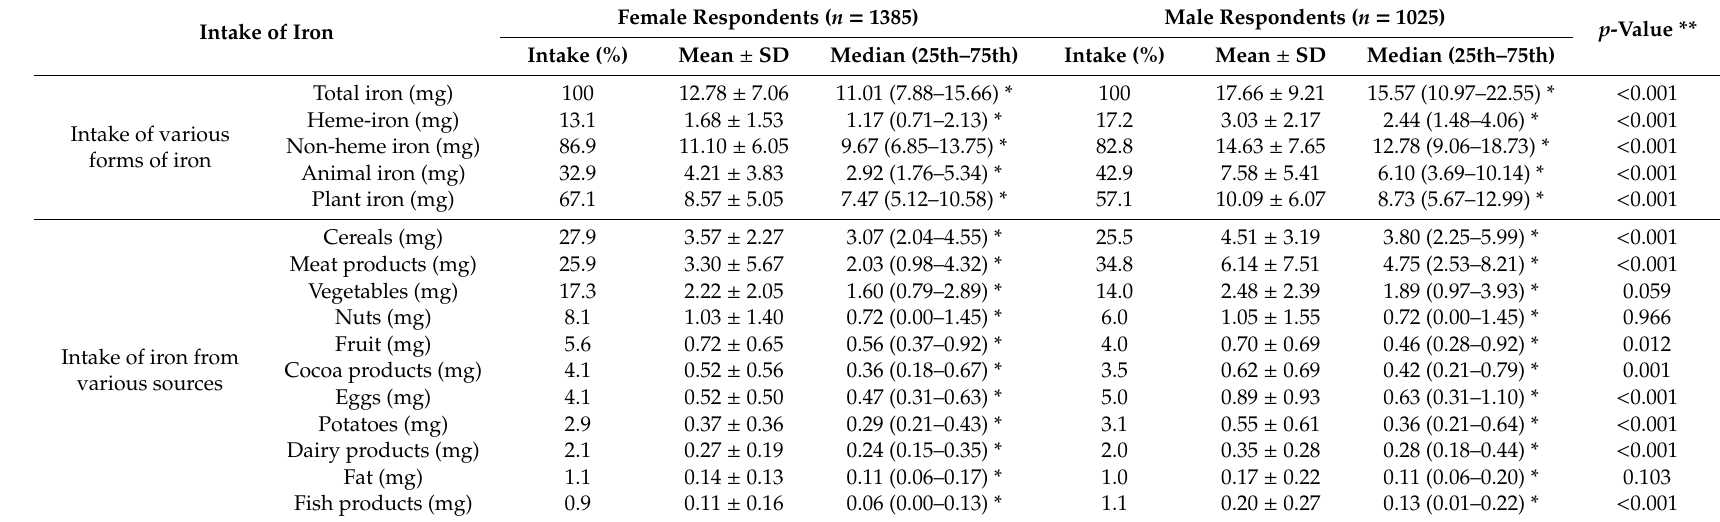
Table 2. Comparison of intake of various forms of iron along with that of iron intake from various sources in the national sample of Polish adolescents, in the sub-groups of female and male